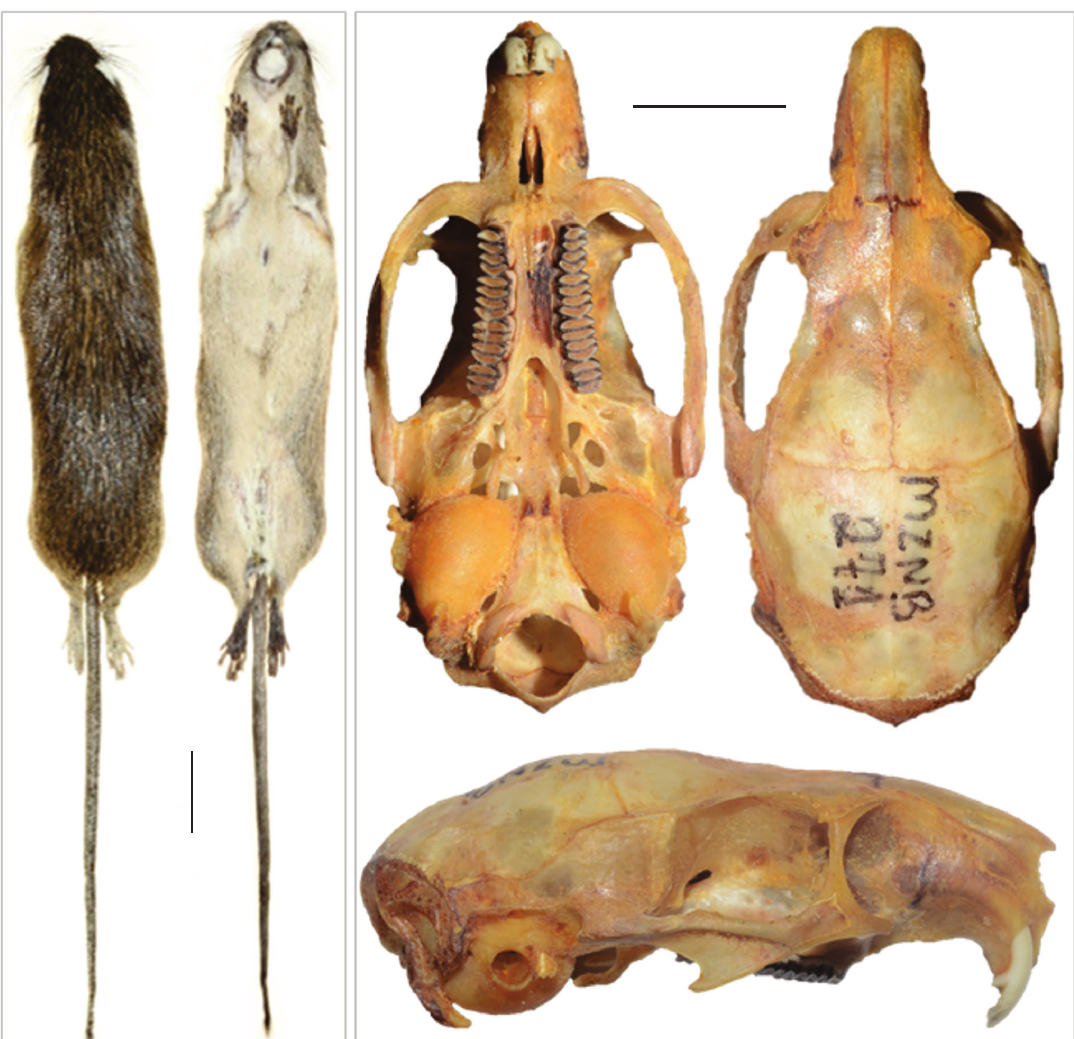
Figure 2. Dorsal, ventral and lateral views of skull and skin of P. lundi female MZNB 271. Scale bars: 1